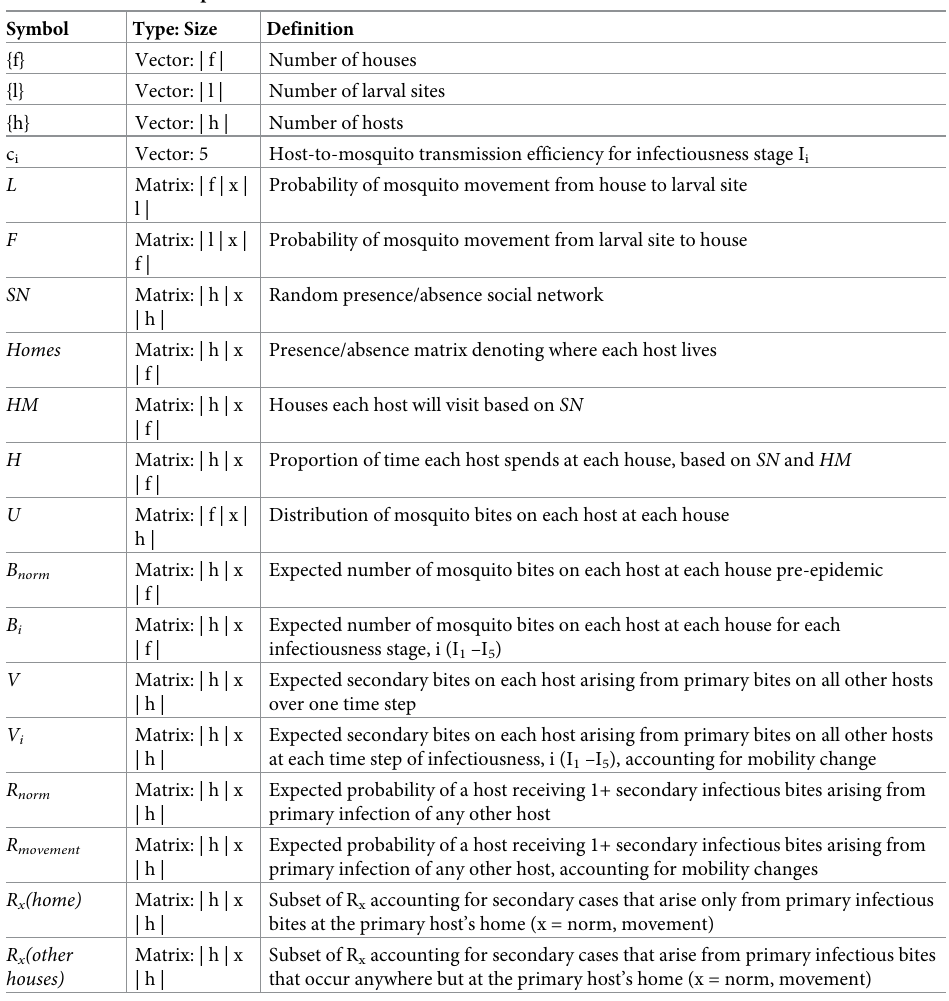
Table 1. Definitions of parameters mentioned in